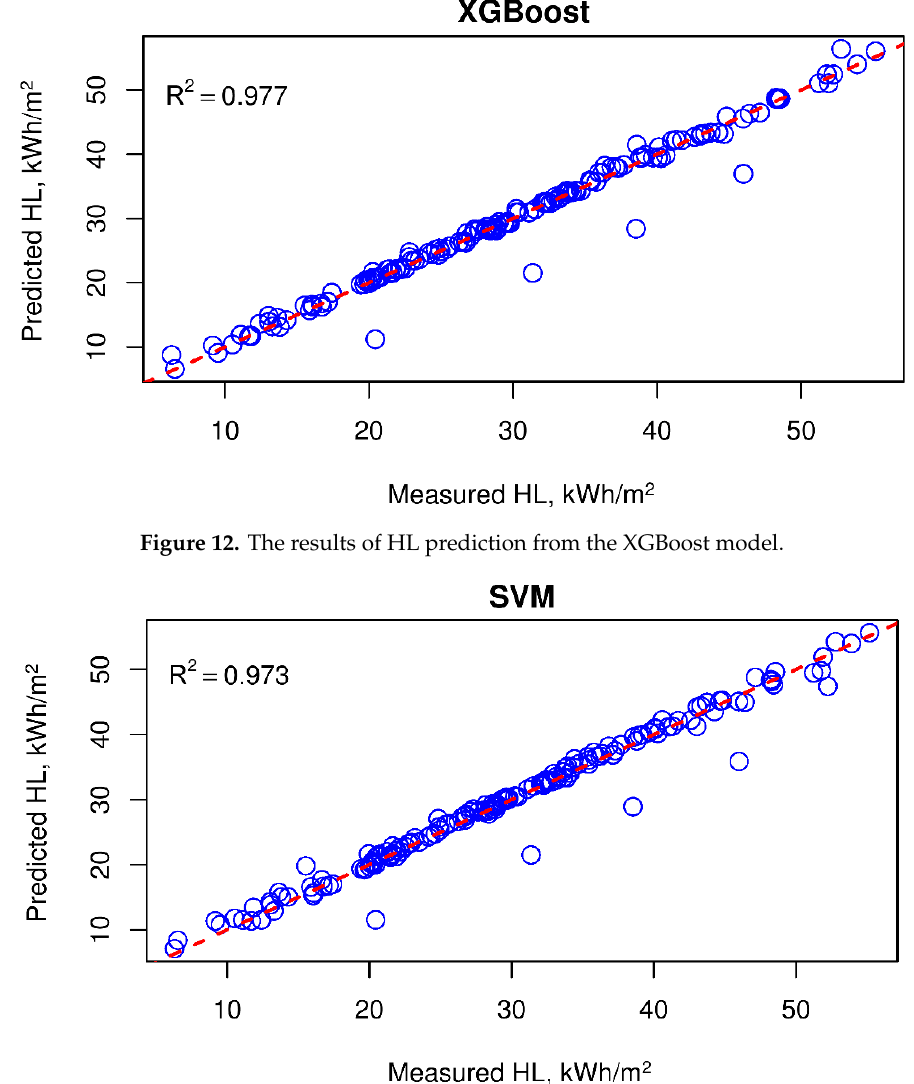
Figure 13. The results of HL prediction from the support vector machine (SVM) model.